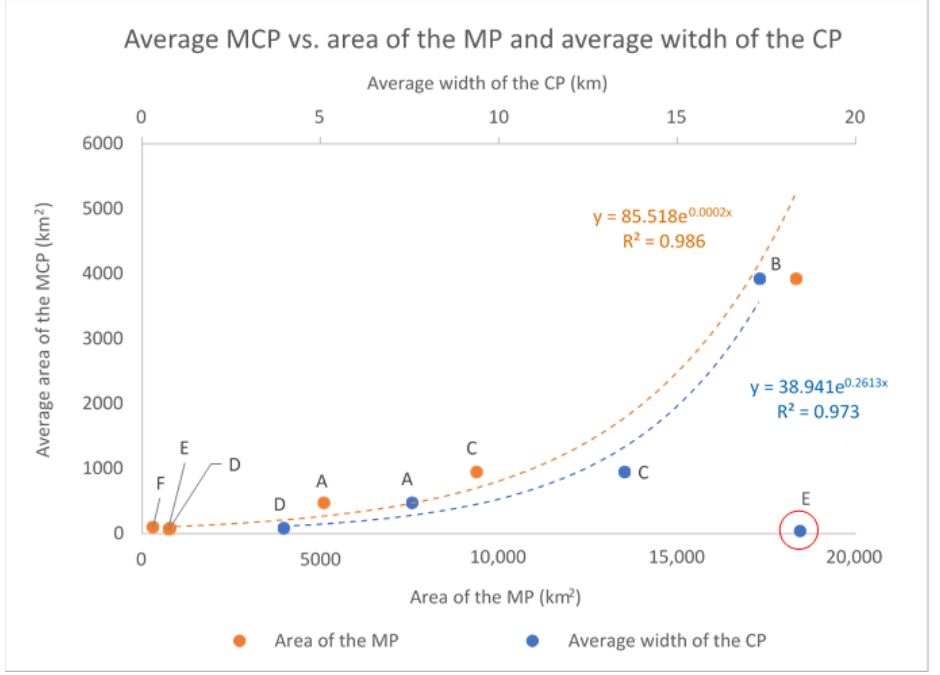
Figure 10. The average MCP and the complex MP of each cluster are positively correlated ( p -value < 0.01) and seem to grow proportionally to the average width of the continental platform in the corresponding area of occupancy, following an exponential curve. Cluster E (whose value was not included in the regression analysis) seems to escape this general pattern, since its average MCP is quite small compared to the available platform. This is due to the limited (inshore) effort carried out in the corresponding study area (see the text for discussion on this point). The average size of the individual MCPs and the size of the MP for each cluster are